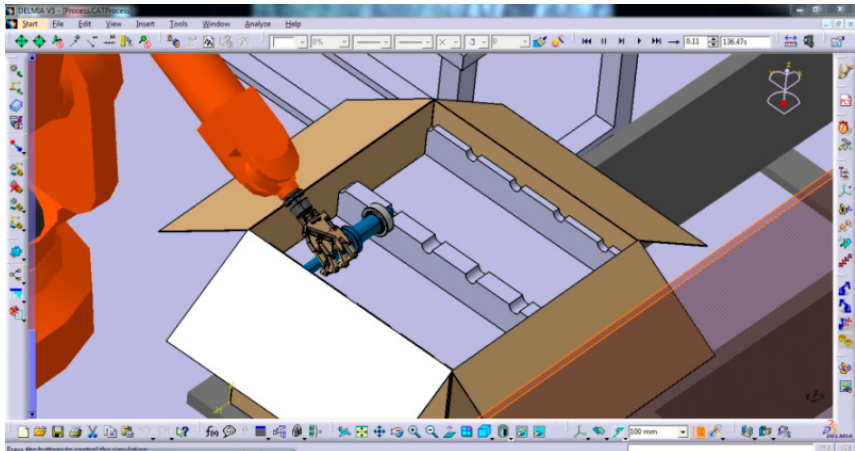
Figure 12. The shaft is stored in a box.